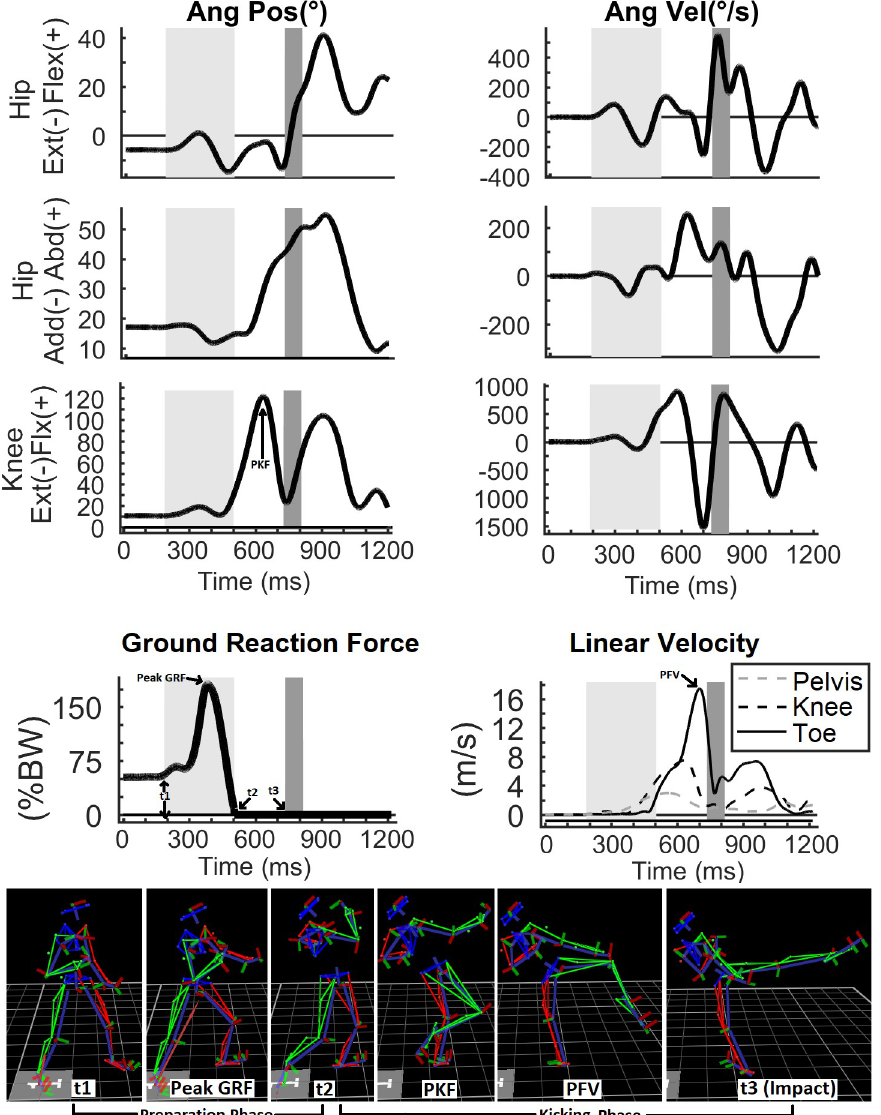
Fig 1. Angular position, velocity, and torque curves of a representative athlete performing a dynamometric evaluation of knee flexion and extension at 60˚/s. The horizontal line is the velocity threshold separating the isokinetic phase from the other phases (acceleration and deceleration); the areas shaded in light green and gray represent the isokinetic extensor and flexor phases respectively.